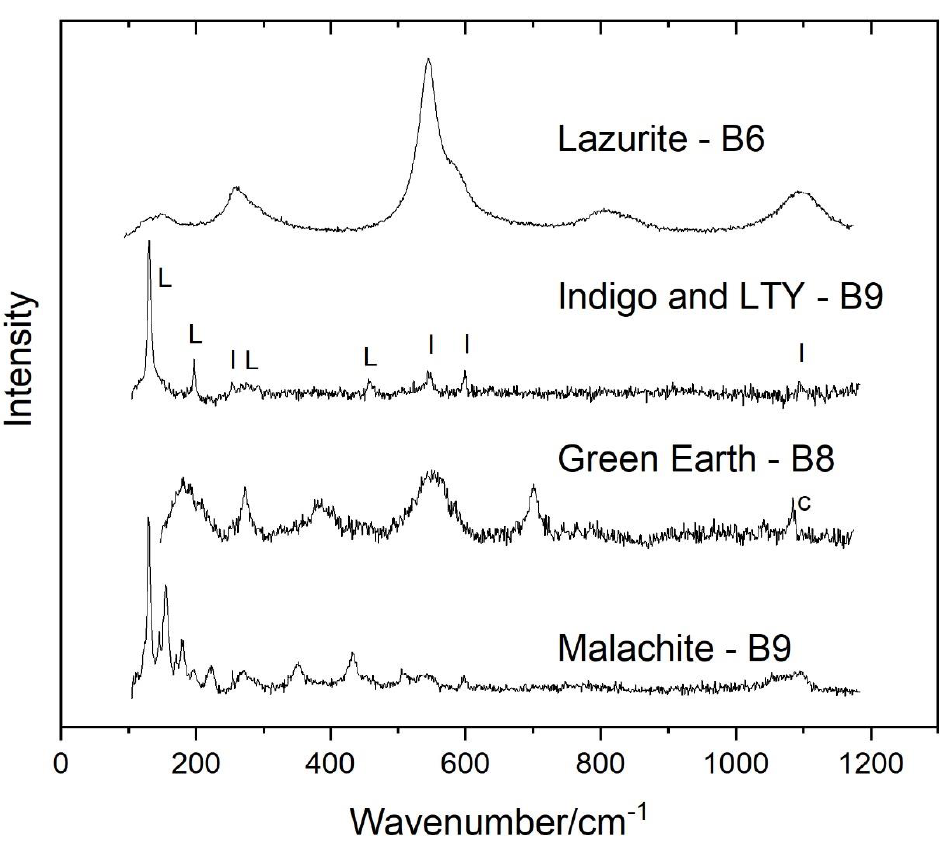
Figure 5. Raman spectra of blue and green pigments. L = Lead tin yellow type I (LTY), I = Indigo, C = Calcite.